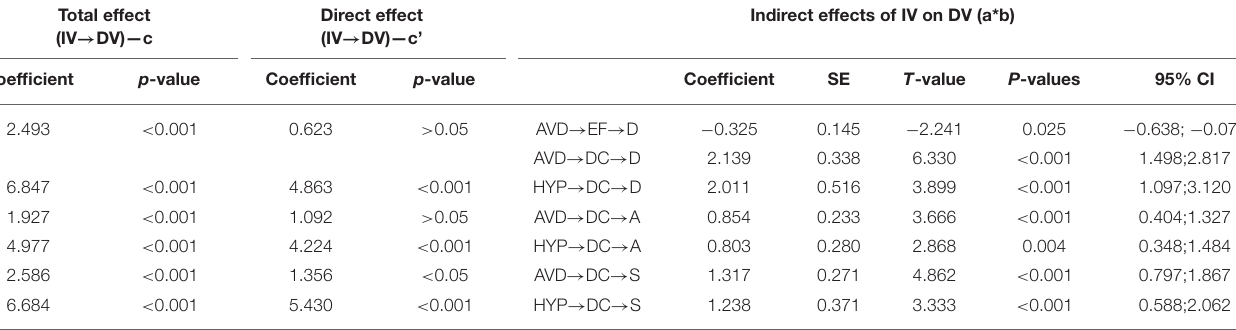
TABLE 6 | Summarized significant mediation pathways including the indirect relationships. Total effect (IV →